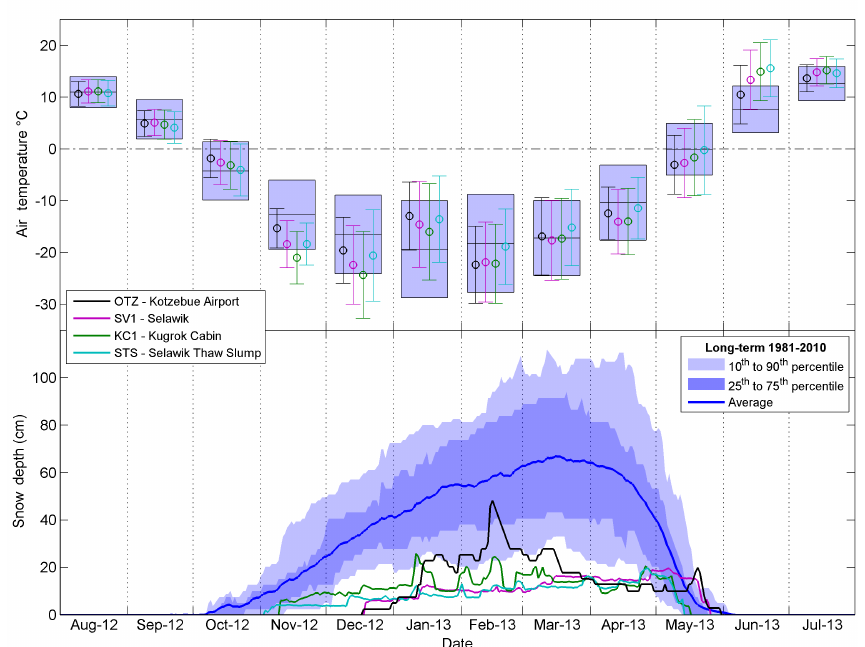
Figure 3. Summary of air temperatures and snow depths for the period August 2012 to July 2013. The top panel shows the mean monthly air temperatures and standard deviations for our core sites and the Kotzebue (OTZ) airport; the blue boxes show the long-term (1981–2010) monthly means and standard deviations from the Kotzebue airport. The bottom panel shows the snow depths on the ground for our core sites and Kotzebue airport, with daily summary statistics for the same long-term